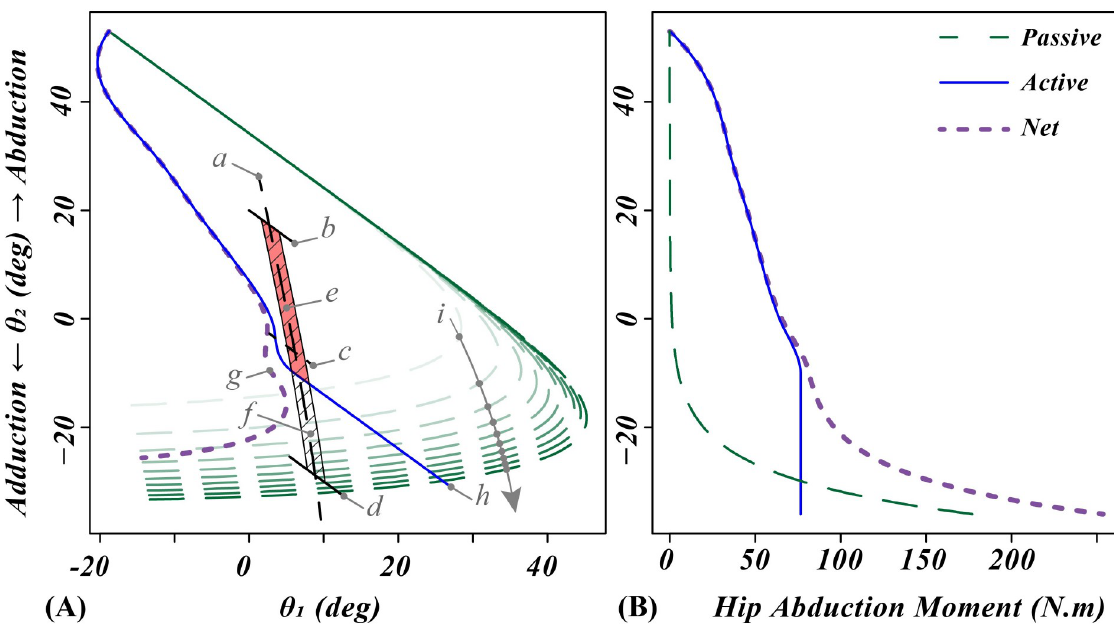
Fig 3. Example of calculated passive tissue contribution to hip abduction moment during OLB in older women with peripheral neuropathy. (A) Calculated effect of passive tissue contribution to the net hip abduction moment on the FBR. Each line in the plot tagged with a small letter in gray shows a locus of quasistatic OLB states where a condition is satisfied: a: zero ankle moment (T S = 0); b: pelvic inclination angle increased 20 º ; c: pelvic inclination angle held level with horizon; d: pelvic inclination angle decreased to -20 º ; e: FBR derived with only active hip abduction strength (red region); f: FBR derived with both active and passive hip abduction moments (region with diagonal lines); g: required hip abduction moment for maintaining the quasistatic state is equal to the net available hip abduction moment; h: required hip abduction moment for maintaining the quasistatic state is equal to the maximum active hip abduction moment strength; i: each green dashed line shows the states where the hip abduction moment from the passive tissues is equal to a percentage of the hip abduction moment load of OLB ranging from 10% to 100% in 10% increments which increase in the direction of the arrow. (B) Available hip abduction moment as a function of hip abduction angle.